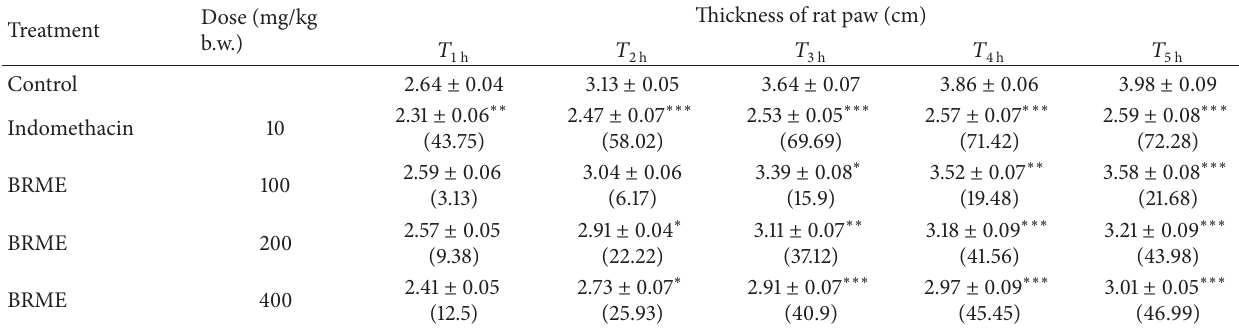
Table 2: Effect of methanolic extract of fruit of Bridelia retusa on histamine-induced paw oedema.